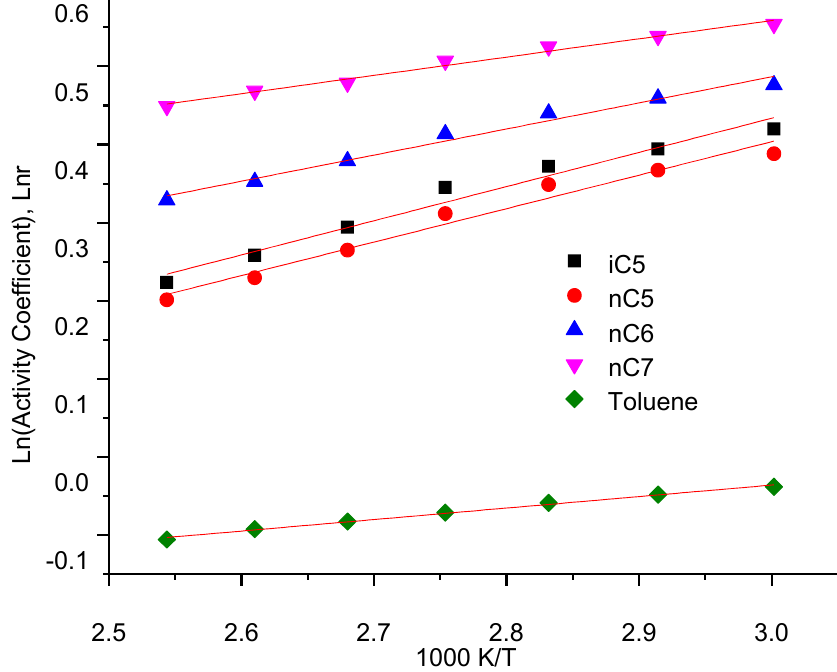
Figure 6. Linear plots for specific retention volume, ln V g , vs. the inverse of absolute tempera- ture T for different dilution: nC5, iC5, nC6, nC7, and Toluene under the asphalting contents of 36.86 wt% asphaltene.